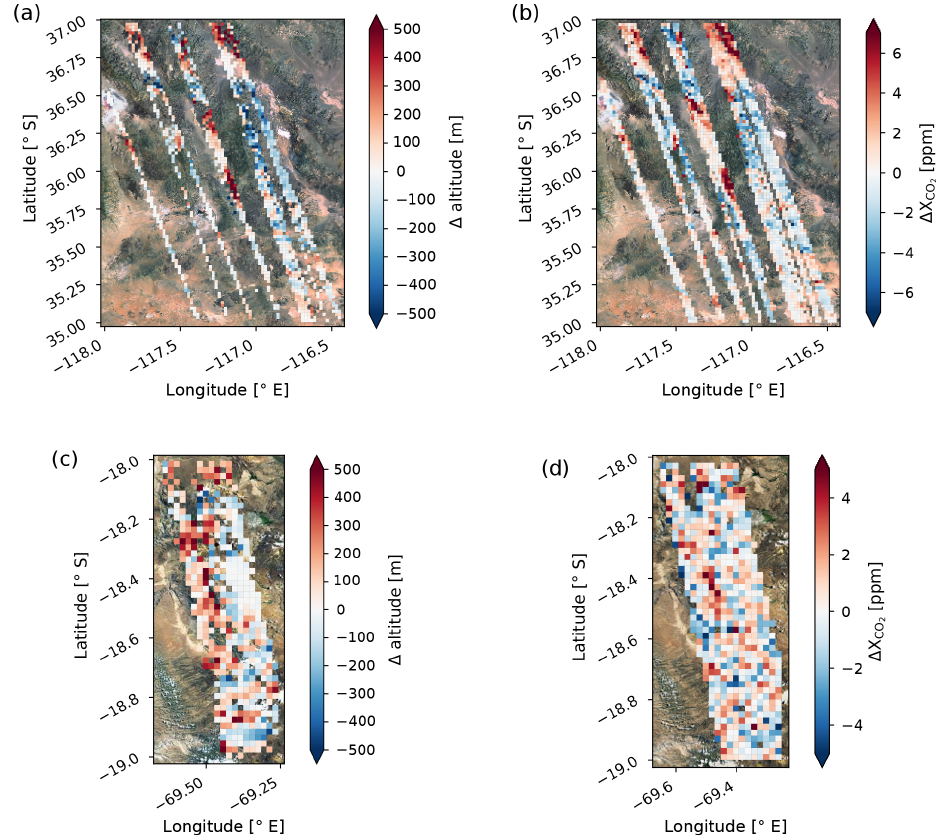
Figure 4. Change in altitude (a, c) over the two selected areas in the Death Valley National Park (a, b) and Atacama Desert (c, d) . The change in altitude is determined from two 0.02 ◦ × 0.02 ◦ latitude–longitude grid squares in the NE direction in the Northern Hemisphere and the SE direction in the Southern Hemisphere; hence the figures have fewer values than for (cid:49) X CO changes of up to 1000m is observed in both areas. A topography-related bias in (cid:49) X CO in both regions. Individual observations are aggregated into 0.02 ◦ × 0.02 ◦ latitude–longitude grid squares.